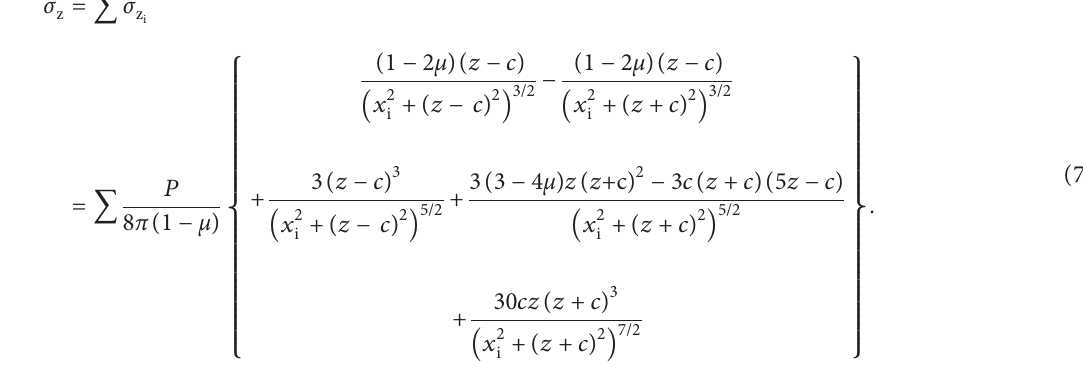
Figure 5: τ xz at different burial depths.